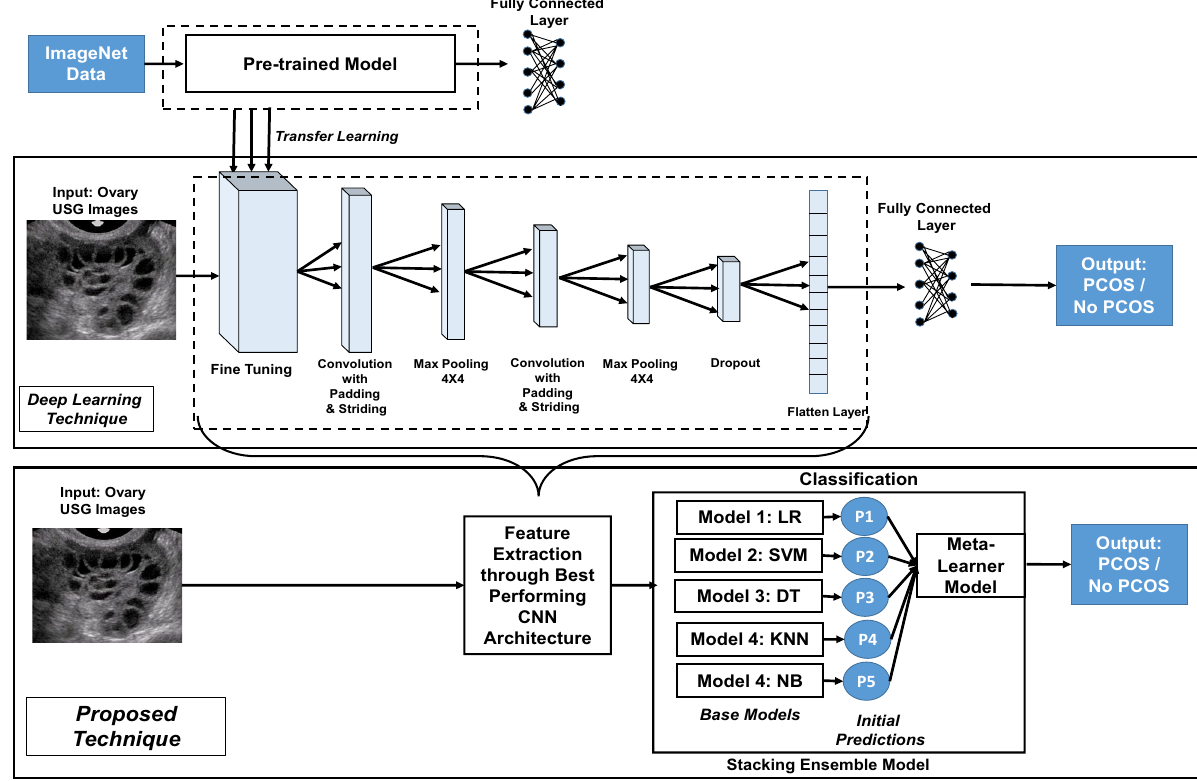
Figure 2. Architecture of deep learning technique and proposed